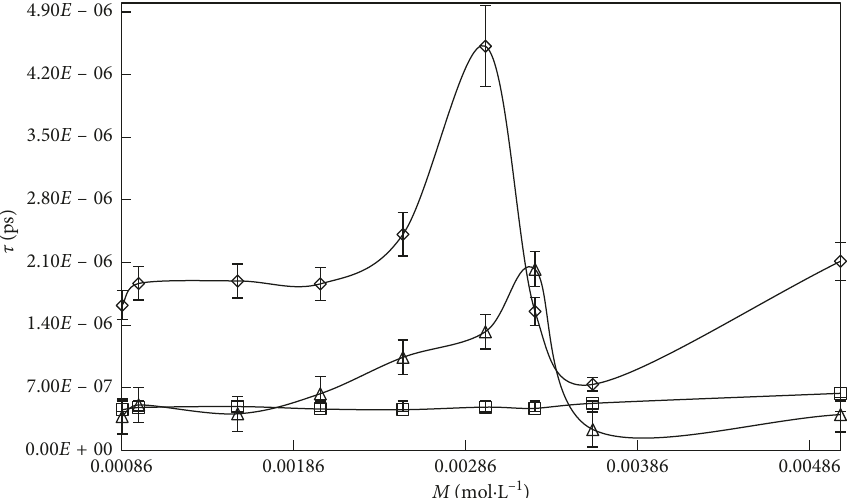
Figure 3: The τ value of the DTAB-rich surfactant at the three different temperatures T � 293.15 ( ◊ ), 298.15 ( □ ), and 303.15K ( △ ),